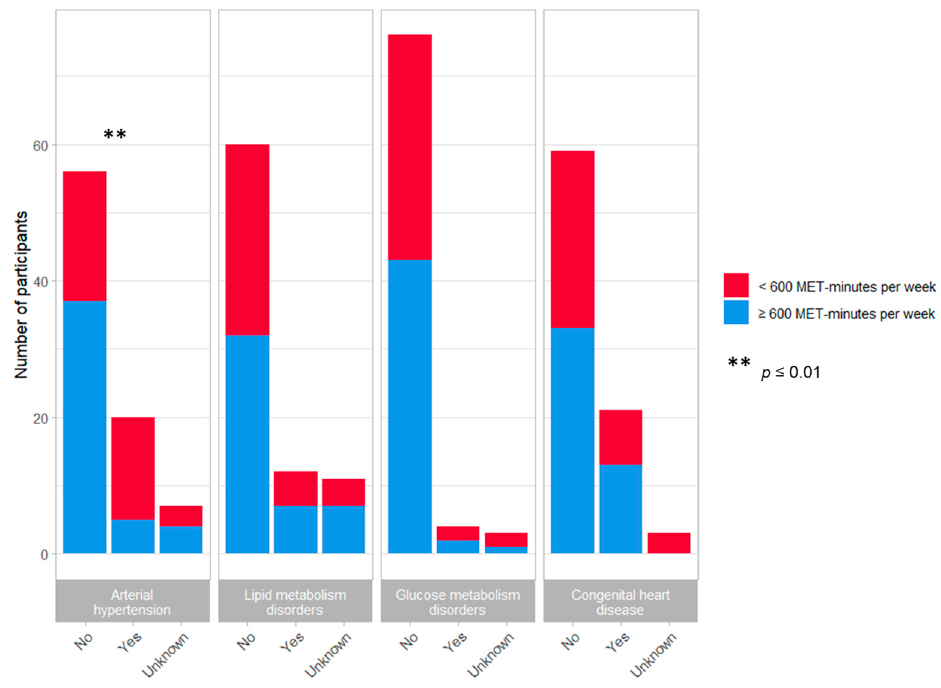
Figure 1. MET-minutes per week for recreational activities and cardiovascular morbidity in Turner syndrome patients. Chi-squared tests or Fisher’s exact test for counts smaller than five were applied to test for significance. ** p ≤ 0.01.